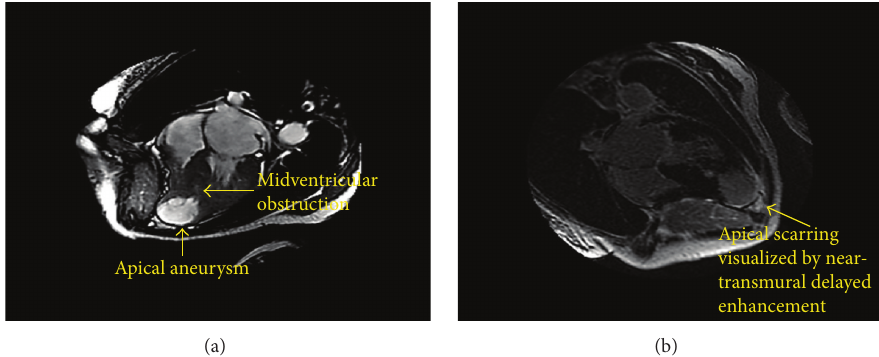
Figure 5: (a) Cine 4-chamber image of cardiac MRI done with steady state free precession imaging (SSFP) demonstrating diffuse hypertrophy with aneurysmal apex. (b) Delayed enhancement 4-chamber MRI image demonstrating thinned apex and apical